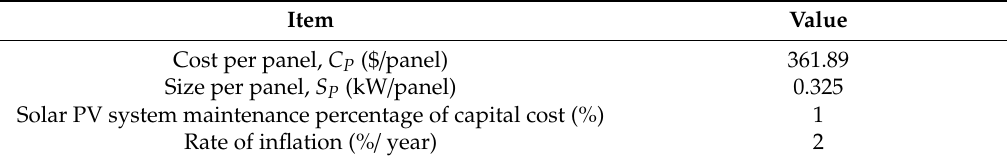
Table 2. Solar PV system costs and details (CAD)